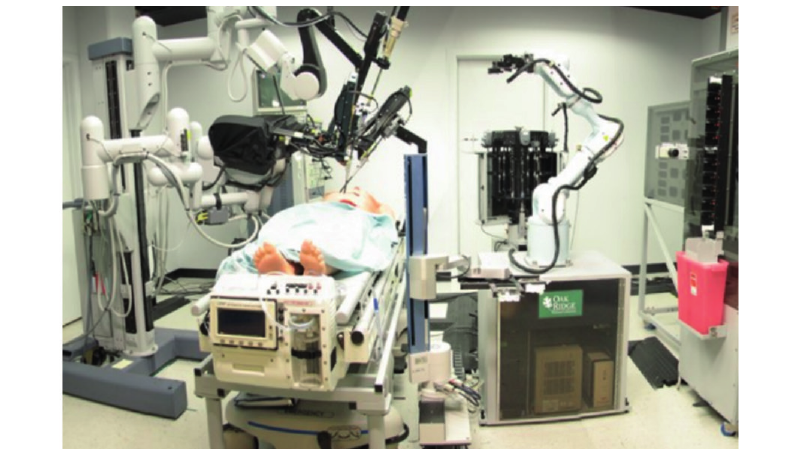
Figure 2. Robot performing surgery (Courtesy: SRI-led Trauma Pod, developed for DARPA).